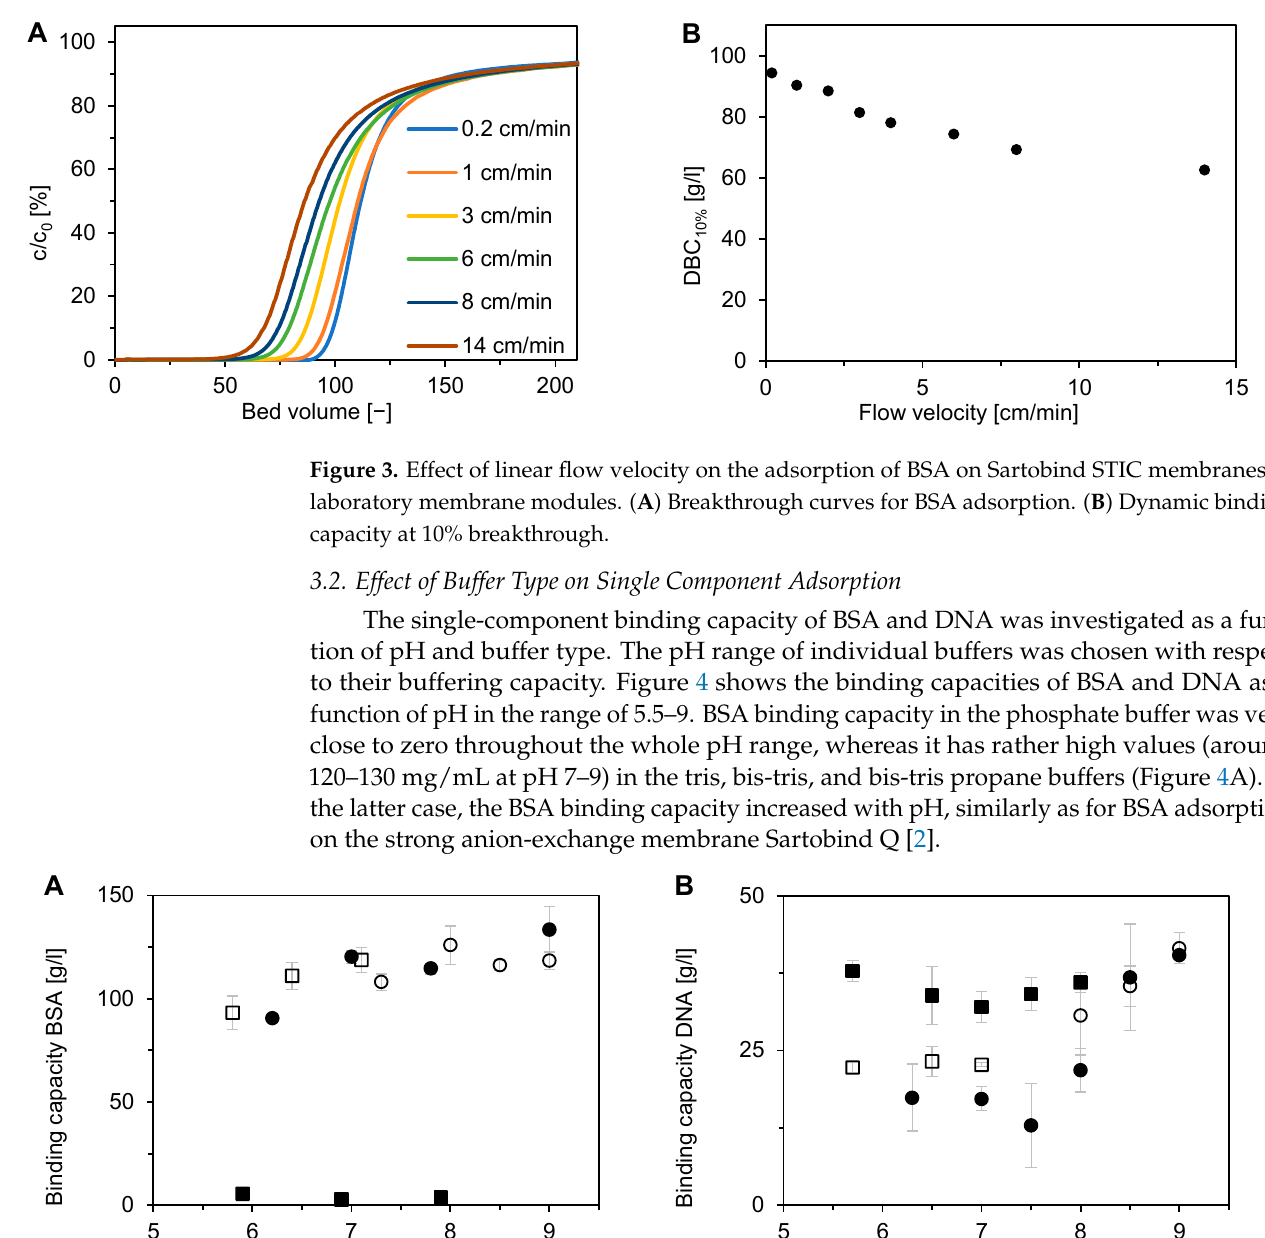
8 of 23 Figure 2. Secondary pore-size distribution coefficient vs. solute hydrodynamic radius for Sartobind STIC membranes obtained by inverse size-exclusion chromatography. The experiments were per- formed in triplicate, error bars represent standard deviations. In general, membrane structure significantly influences the membrane transport properties, which are typically represented by the dynamic binding capacity (DBC). DBC is primarily a function of flow velocity. The advantage of adsorption membranes com- pared to particle adsorbent beds is that convective transport is dominant and DBC is much less dependent on the flow velocity. In fact, several papers presented essentially constant DBC for several proteins, including BSA, but at relatively low flow velocities, typically lower than 1 cm/min [7,12,33] and maximally at 5 cm/min [34]. In this work, we examined the effect of linear flow velocity on the DBC of BSA in a broad range from 0.2 cm/min to 14 cm/min. Figure 3 shows that DBC decreased slightly with linear flow velocity. The pre- sented results are compatible with the previous observations in that the effect of linear